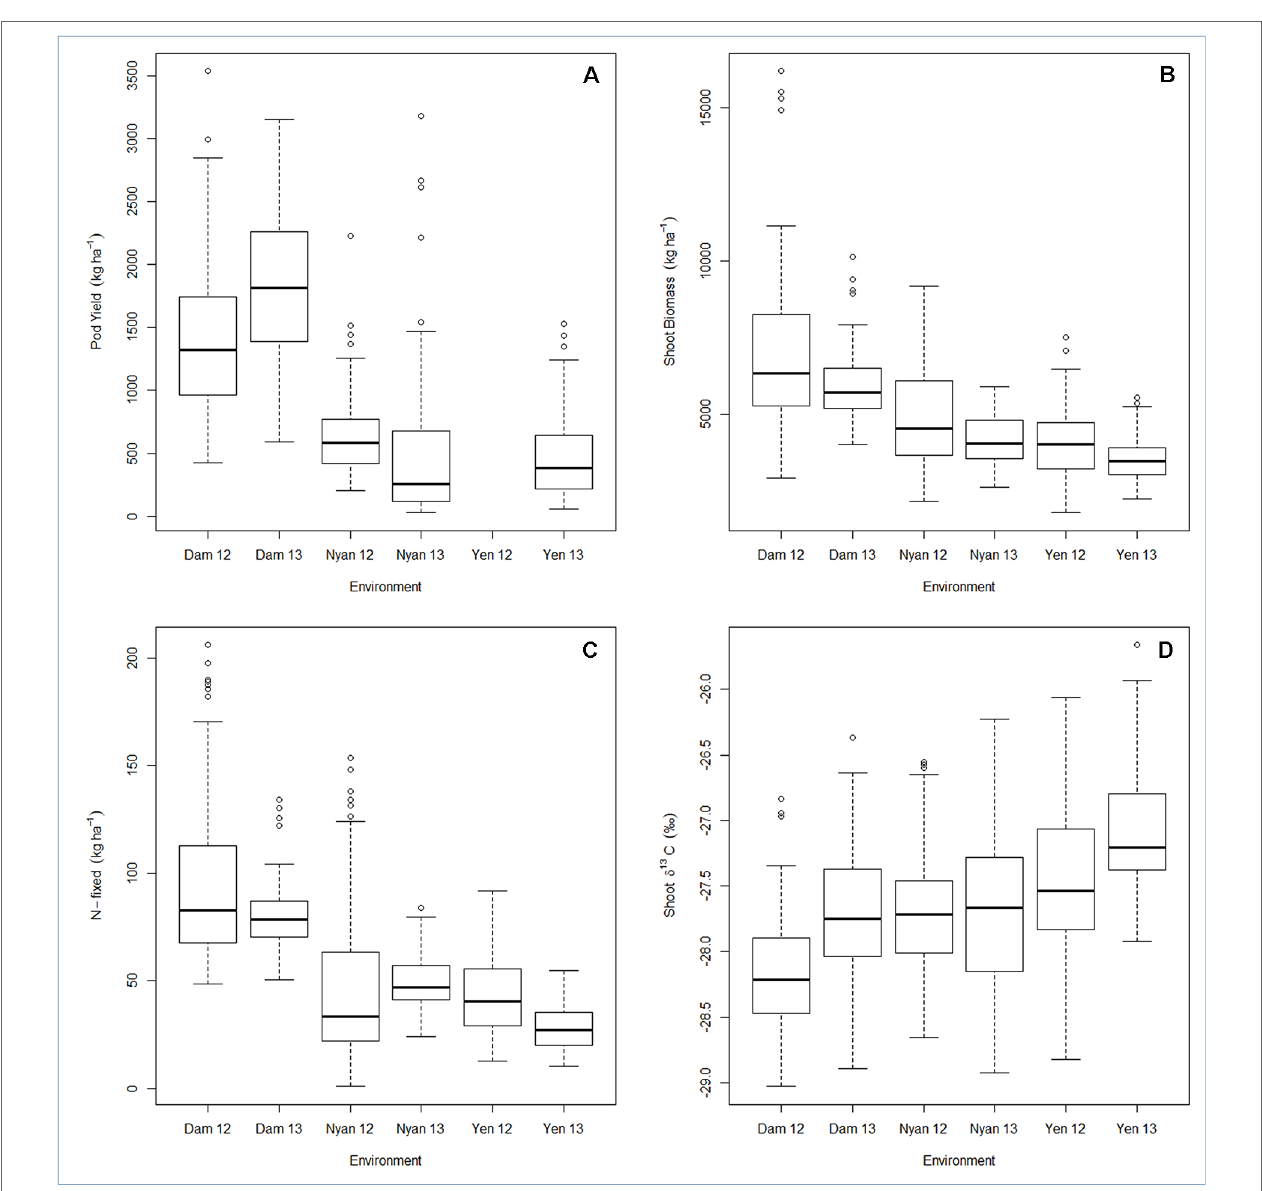
FIGURE 1 | Box plot for (A) pod yield, (B) shoot biomass, (C) N-fixed, and (D) shoot δ 13 C displaying the total range, interquartile range, and median. Environment names are coded as Dam, Damongo; Nyan, Nyankpala; Yen, Yendi. The 12 refers to 2012, while 13 refers to 2013.